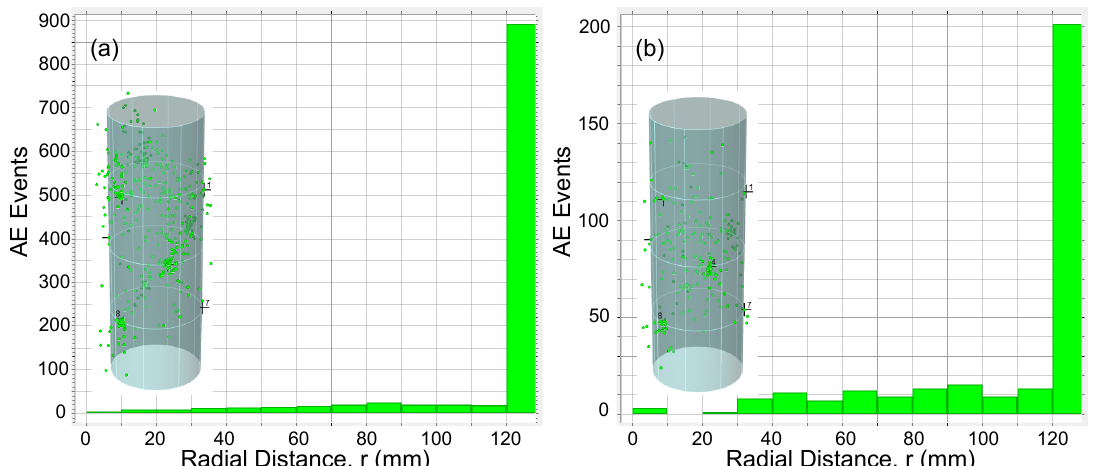
Figure 13. AE events along specimen F06S120S cross section for ( a ) t < 500s and ( b ) t ≥ 500s.